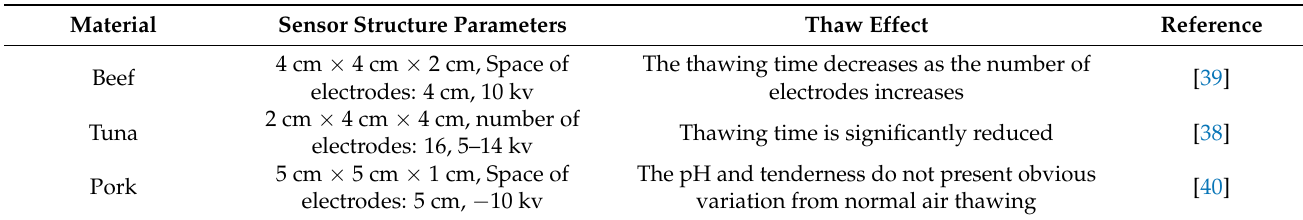
Table 2. Comparison of the thawing meat products under high-voltage electrostatic field. Material Sensor Structure